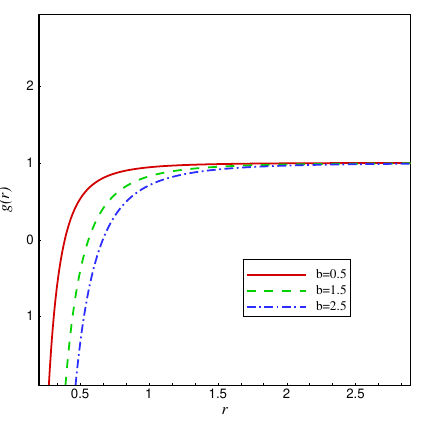
Figure 6 . The behavior of g ( r ) for charged rotating black string for large r limit with (cid:3) =